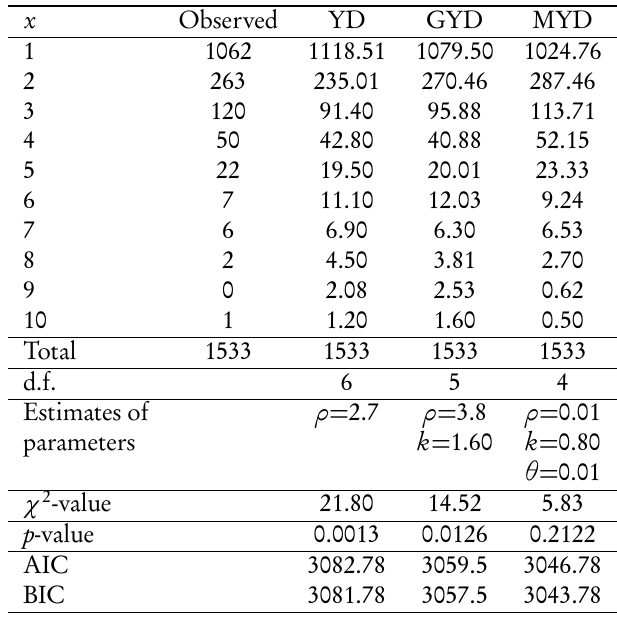
Observed frequencies and computed values of expected frequencies of the MYD, the GYD and the YD by the method of maximum likelihood for the first data set.